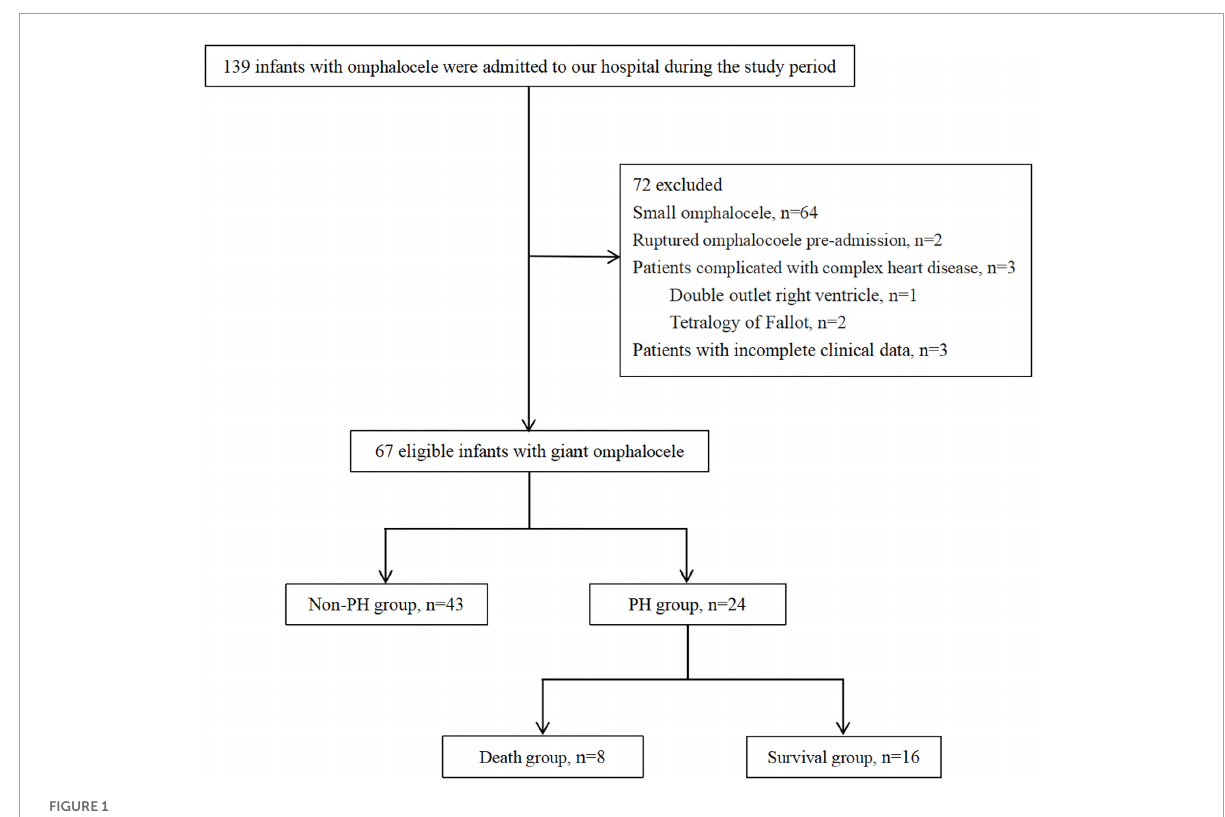
FIGURE1 Flowchart of